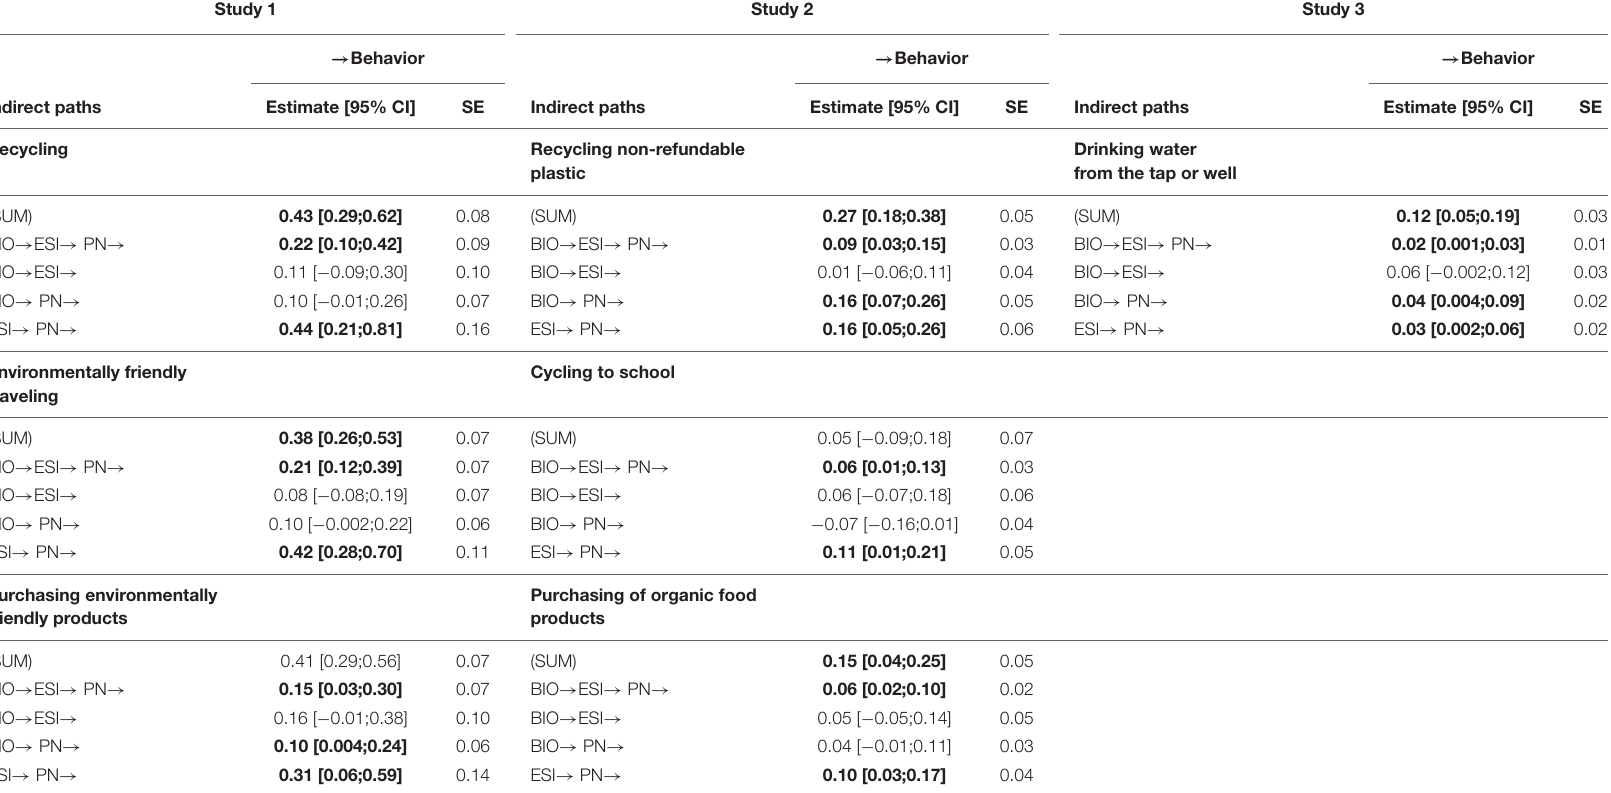
TABLE 2 | The indirect effects of adolescents’ biospheric values and environmental self-identity on pro-environmental